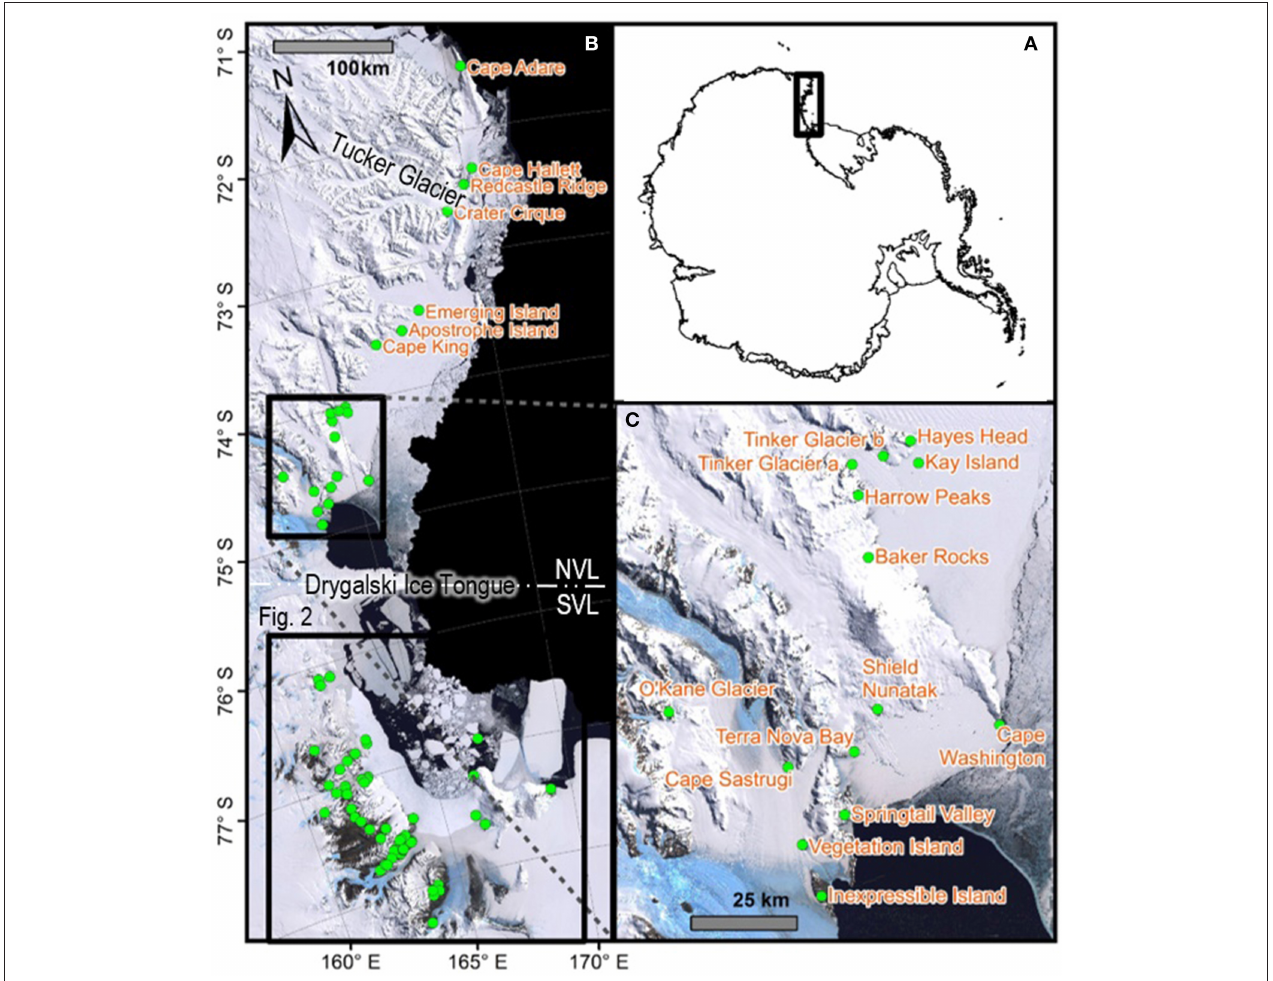
FIGURE 1 | Map with all 21 sites in northern Victoria Land labeled, including (A) an overview map showing the location of Victoria Land within the Antarctic continent, (B) all 88 sites within Victoria Land from which COI sequences were obtained and presented in the current study, for the seven species in this area, and (C) a zoomed-in portion of NVL to display site names. Generated in ArcMap v10.5.1. See Table 2 and Table S1 for GPS